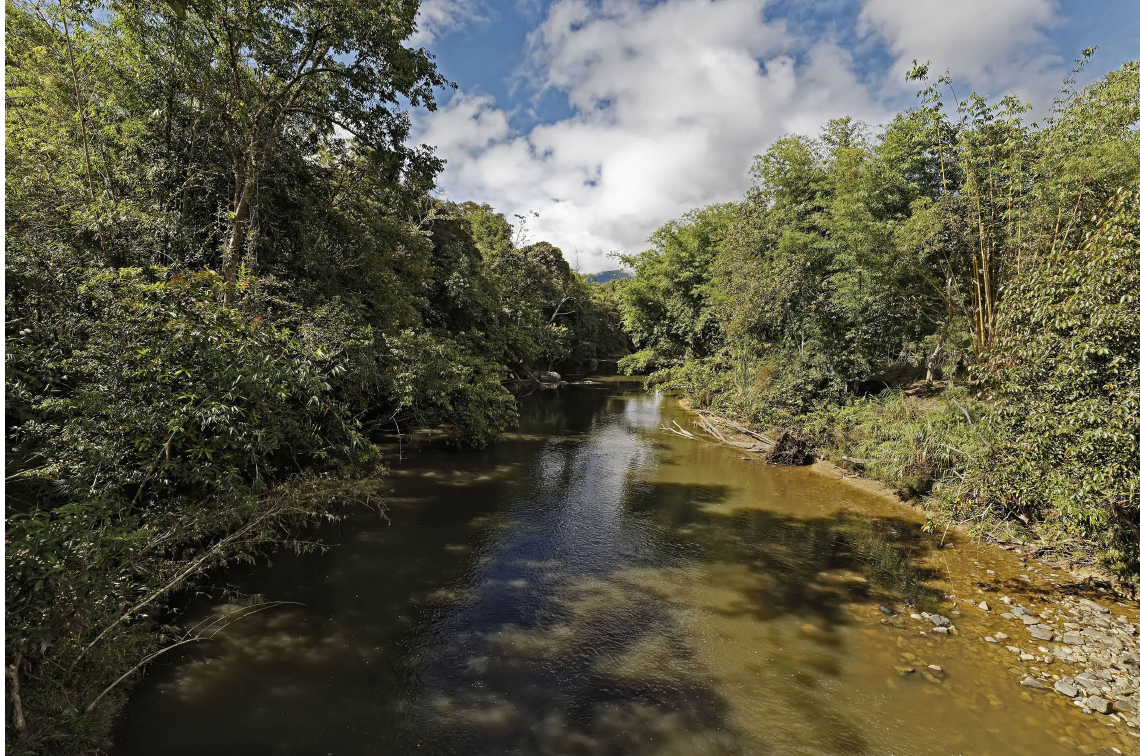
Fig. 5. The Pa’Kelapang River at Ramudu near the locality where Potamophilus kelabitensis sp. nov. was